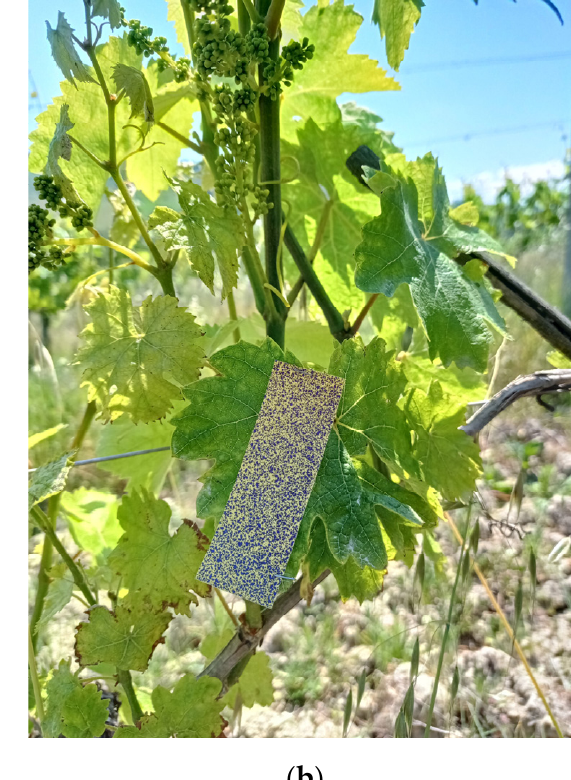
Figure 4. Vineyard rows divided into three blocks for the LiDAR and standard tests: yellow to red blocks are respectively LiDAR blocks from 1 to 3, while light blue to dark blue blocks are respectively Standard blocks from 1 to 3.